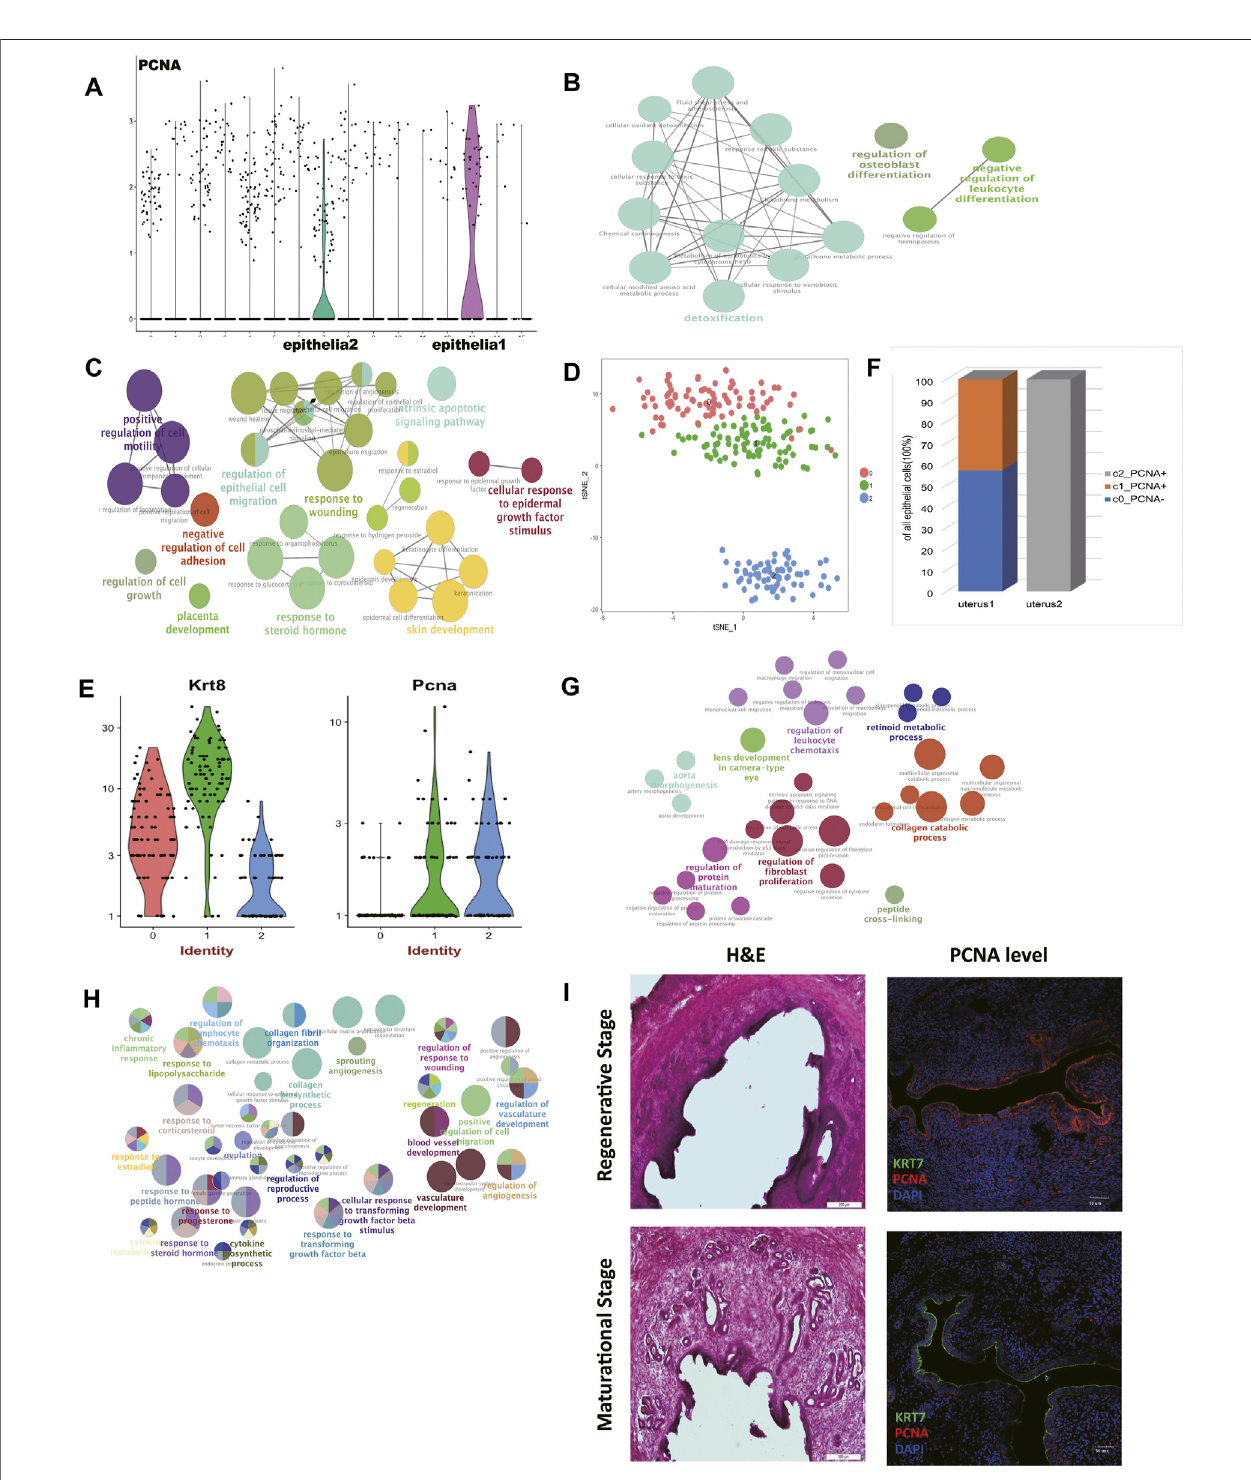
FIGURE2| Comparisonofepithelialcellsandstromalcellsrevealedtwouteriofdistinctestrusstages. (A) Pcna washighlyexpressedinepithelialcells1compared to epithelial cells 2. Gene ontology (GO) analysis of differentially upregulated genes in (B) epithelial cells 1 and (C) epithelial cells 2. (D) t-distributed stochastic neighbor embedding(t-SNE)diagramofepithelialcellsintwomiceuteri. (E) Pcna washighlyexpressedinsub-cluster1andsub-cluster2. (F) Theepithelialcellcompositionofthe two uteri was signi fi cantly different. Gene ontology (GO) analysis of differentially upregulated genes of stromal cells in (G) the regenerative stage and (H) the maturational stage. (I) Representative H&E and IF staining of PCNA expression levels in mice endometrium. (DAPI, blue; PCNA, red; KRT7, green). Scale bars, 200 μ m (H&E) and 50 μ m (IF). GO: Gene ontology; t-SNE: t-distributed stochastic neighbor embedding; PCNA: proliferating cell nuclear antigen; IF: immuno fl uorescence; H&E: hematoxylin and